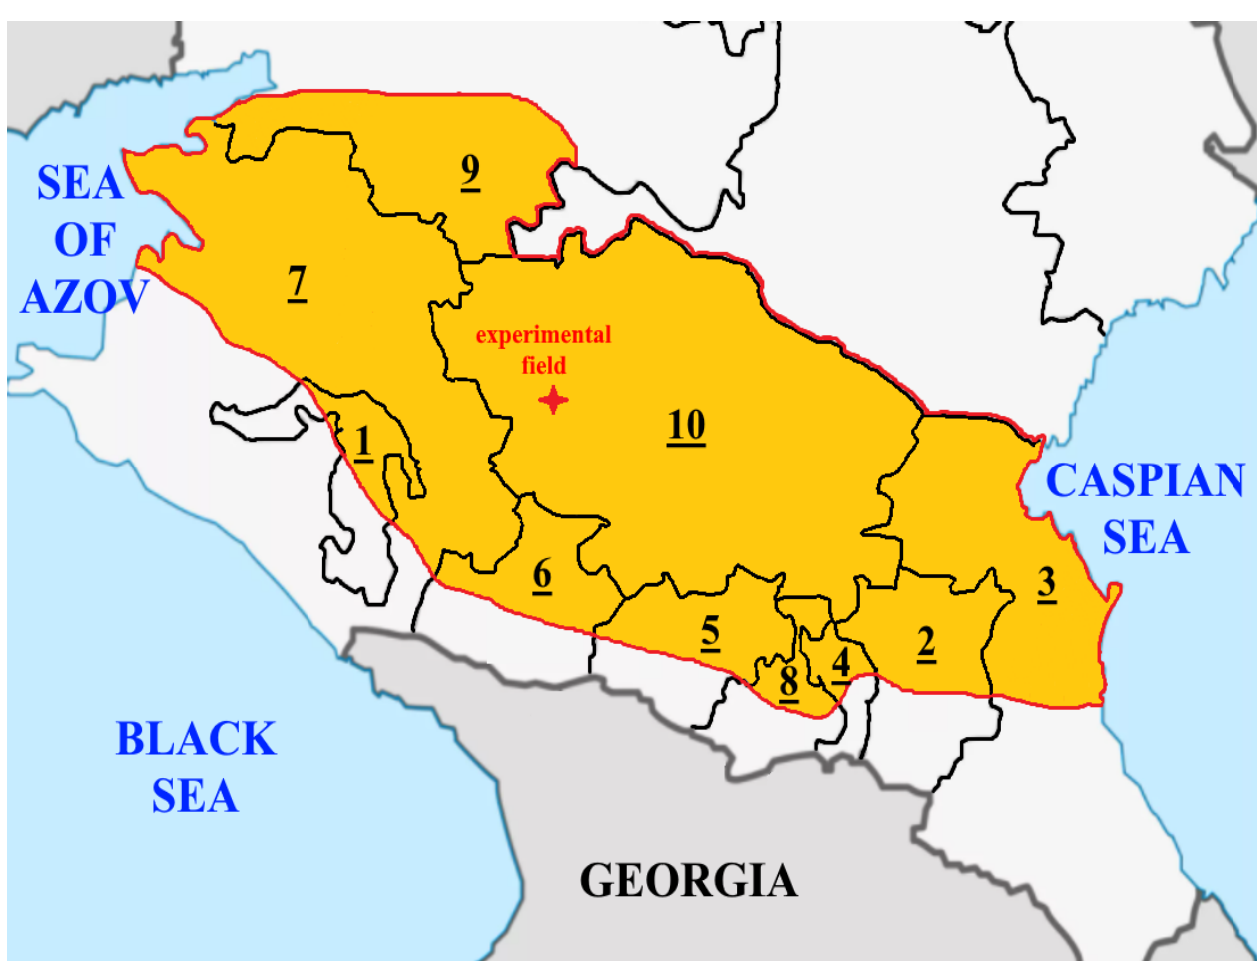
Figure 1. Central Fore-Caucasus: arid zone and the experimental field. Note: 1 = Adygeya; 2 = Chechnya; 3 = Dagestan; 4 = Ingushetia; 5 = Kabardino-Balkaria; 6 = Karachaevo-Cherkessia; 7 = Krasnodar; 8 = North Osetia- Alania; 9 = Rostov; 10 = Stavropol. Source: authors’ development.